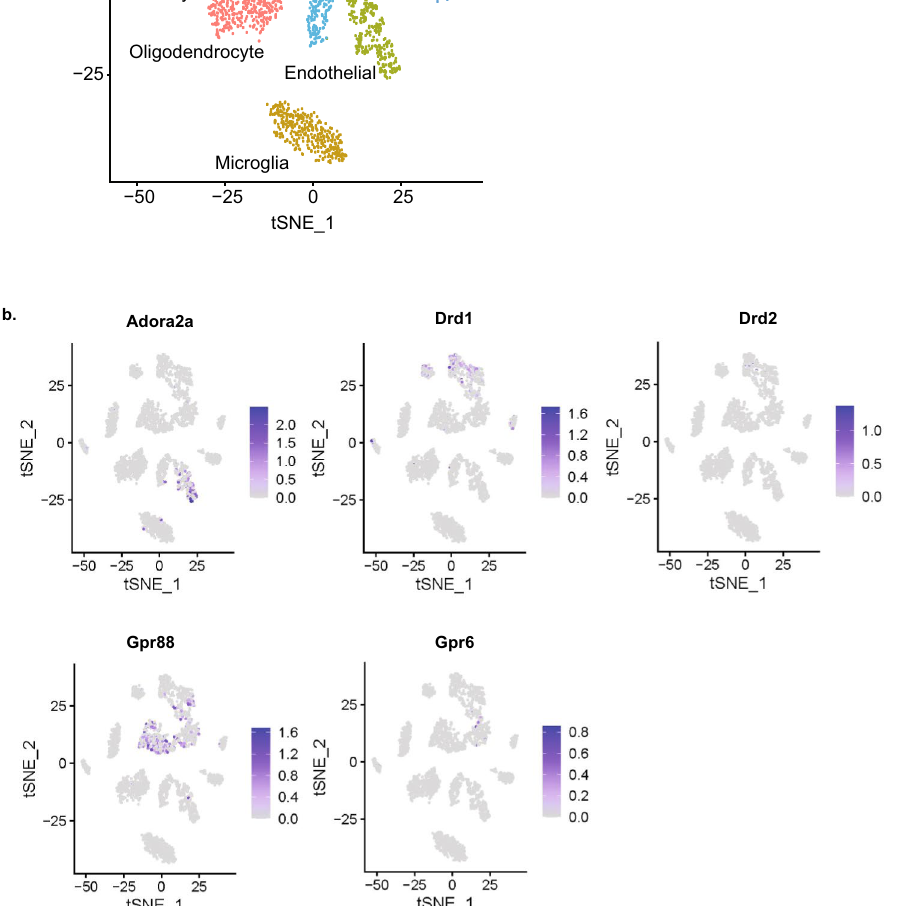
Figure 3. Cell type specific expression of the relevant genes in mouse PFC. ( a ) t-SNE plot representing different cell type clusters in PFC. t-SNE plot representing the clusters of the different cell subtypes in PFC based on the transcriptome of cocaine self-administration mice during the habituation phase from Bhattacherjee et al. 14 . ( b ) t-SNE plot representing some of the common upregulated genes found in cocaine and food addiction